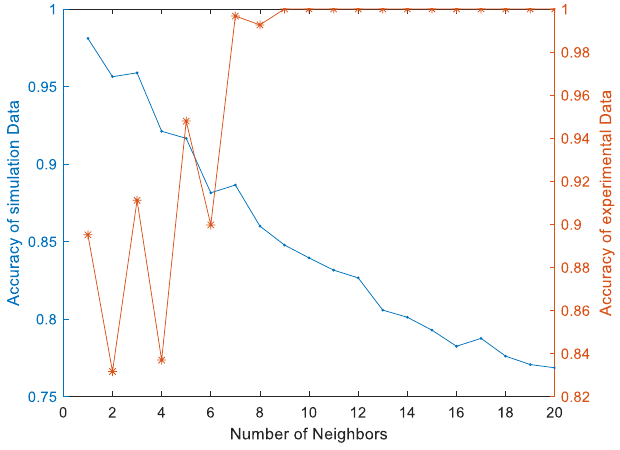
Figure 9. Number of neighbors vs. accuracy of simulation data (in blue) and experimental data (in red) .